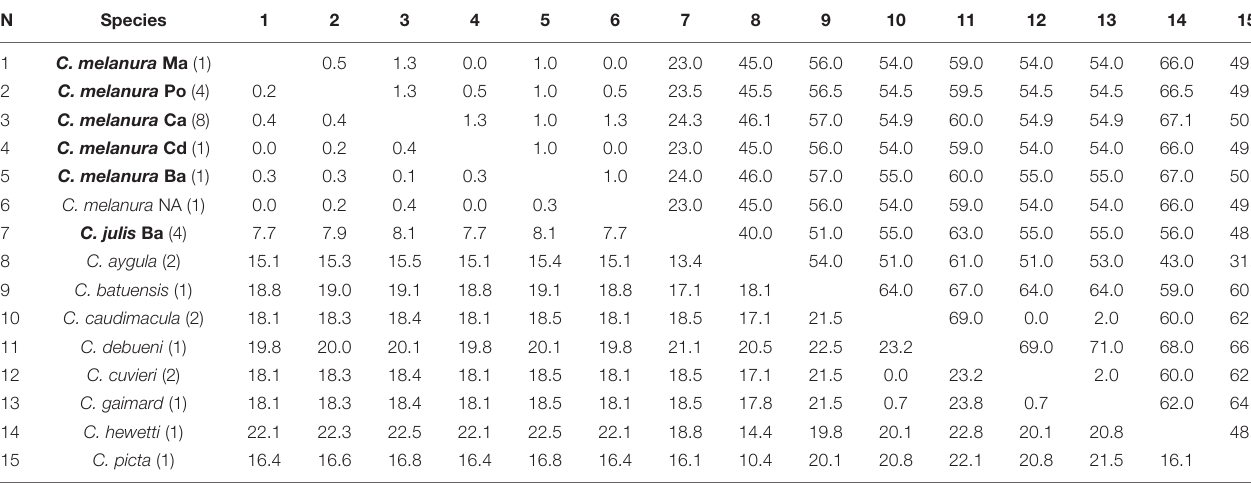
TABLE 6 | Mean genetic distances (%) and numbers of base differences for CYTB from Coris species below and above the diagonal,